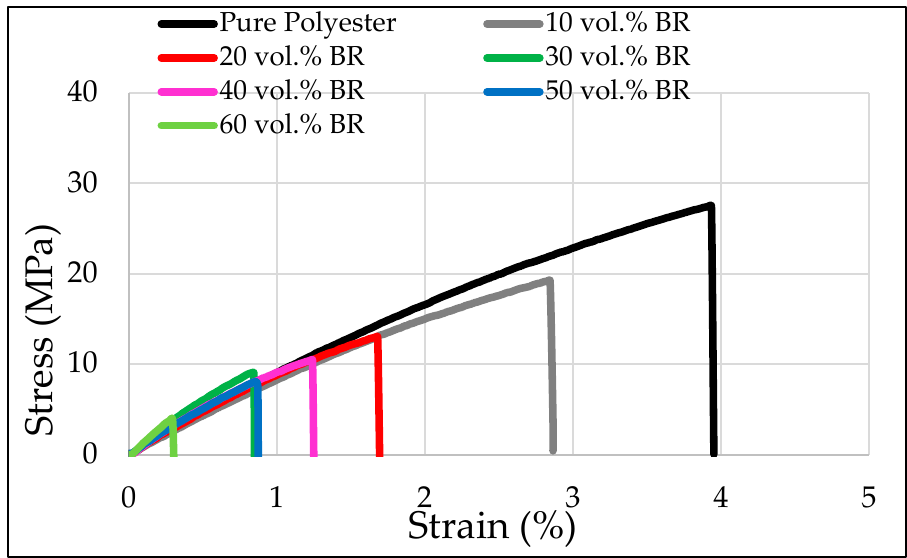
Figure 7. Tensile stress–strain curves of BR–UPR composites.